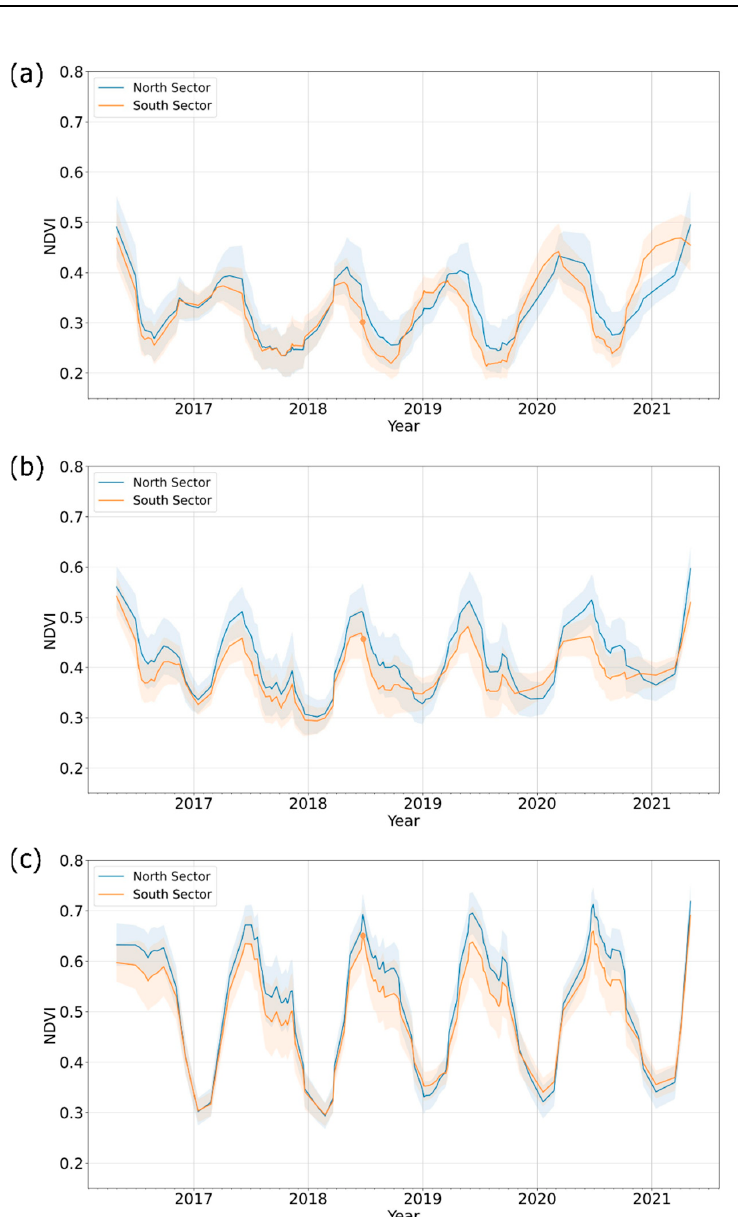
Figure 2. Time-series of median and median absolute deviation (shaded areas) of NDVI in ( a ) herbaceous, ( b ) shrubs, and ( c ) tree-dominated areas. Vertical gridlines indicate the first day of each year, and the orange dot marks the start date (June 2018) of the grazing intervention in the south sector.